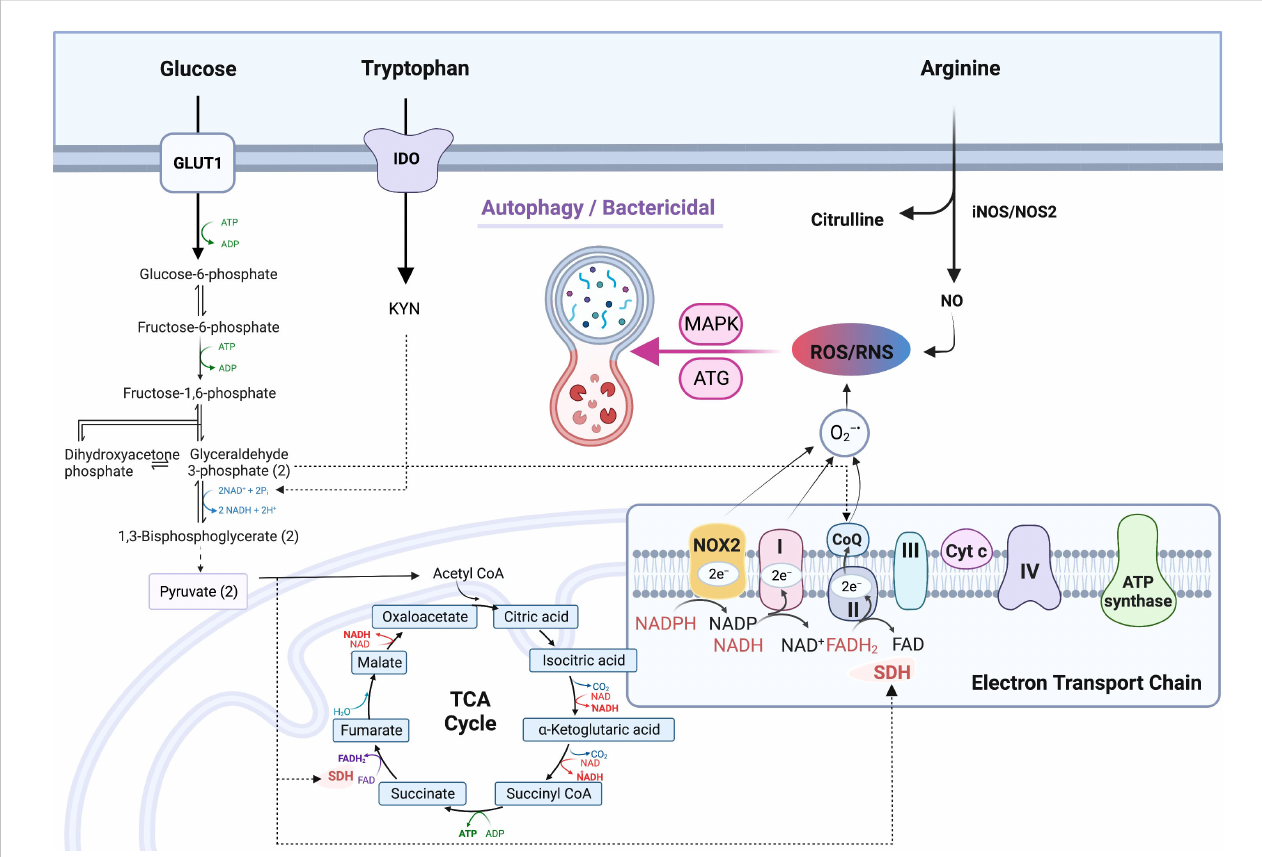
FIGURE 2 Up-regulated production of reactive oxygen species (ROS) and reactive nitrogen species (RNS) in M1- macrophages. Increased production of NADH from reduction of NAD + via glycolysis fuels the electron transport chain (ETC) complex 1 to generate O 2.- ; NAD + is continuously replenished by upregulated NAD + de novo synthesis from tryptophan metabolism. Increased production of NADPH via the pentose-phosphate-pathway (PPP), which is also up-regulated in M1- type macrophages (M F s), fuels the ETC to produce O 2.- . O 2.- is also generated via succinate dehydrogenase (SDH) which is coupled with FADH2/FAD redox reaction in complex II of ETC. In M1-M F s, RNS is derived from nitric oxide (NO) which is produced by arginine metabolism through iNOS/NOS2. Mitochondrial ROS/RNS regulates phagocytosis, bacterial killing, and polarization towards M1-M F s via ATG and MAPK activation. Additional symbols: 1,3-BPG, 1,3-bisphosphoglyceric acid; a -KG, alpha-ketoglutarate; ATG, Autophagy regulating gene; CIT, citrate; DHAP, dihydroxyacetone phosphate; F-1, 6-P, Fructose-1, 6-biphosphate; F-6-P, Fructose-6-phosphate; FUM, fumarate; G-3-P, glycerol-3-phosphate; G-6-P, glucose-6-phosphate; GABA, g -aminobutyrate; GA, glutaminase; GABA-T, GABA transferase; GAD, glutamate decarboxylase; GDH, Glutamate dehydrogenase; Gln, glutamine; Glu, glutamate; GLUT1, glucose transporter protein type 1; iCIT, isocitrate; IDO, Indoleamine-pyrrole